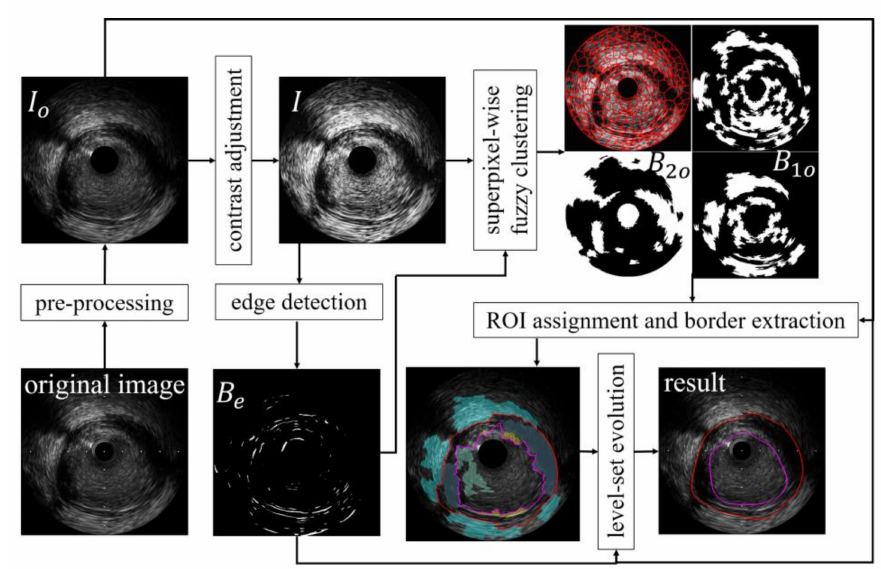
Figure 2. The flowchart of the proposed segmentation